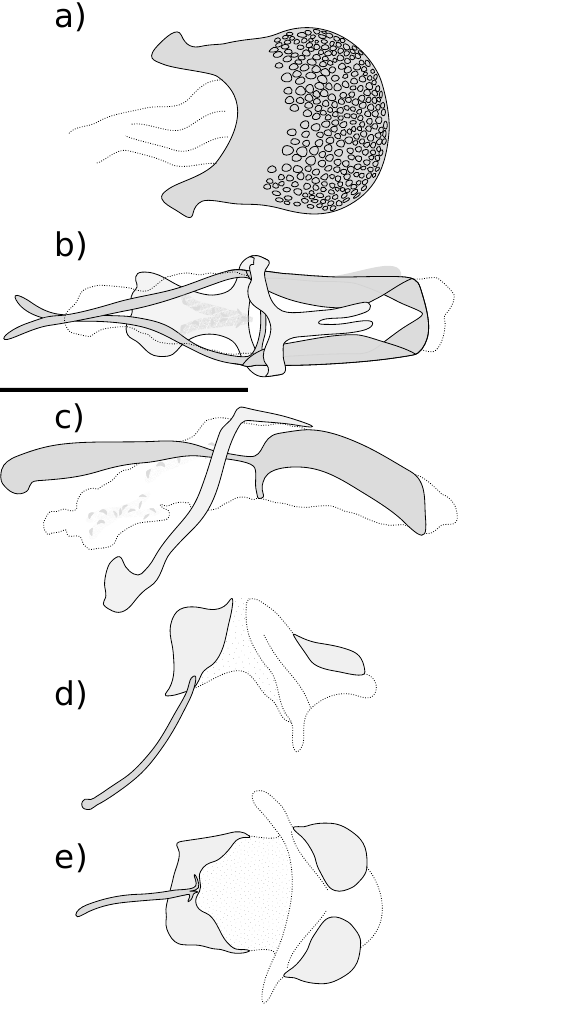
Figure 6. Male and female genitalia of Kuschelysius hollowayae . ( a ) male tergite 8, dorsal view; ( b ) aedeagus, dorsal view; ( c ) aedeagus, lateral view; ( d ) male sternite 8, lateral view; ( e ) male sternite 8, ventral view; ( f ) female tergite 8, lateral view; ( g ) female tergite 8, dorsal view; ( h ) gonocoxites and bursa copulatrix, dorsal view; ( i ) gonocoxites, bursa copulatrix and spermatheca, lateral view; ( j ) female sternite 8, ventral view. Scale bars = 1 mm, a–e at same scale, f–j at same